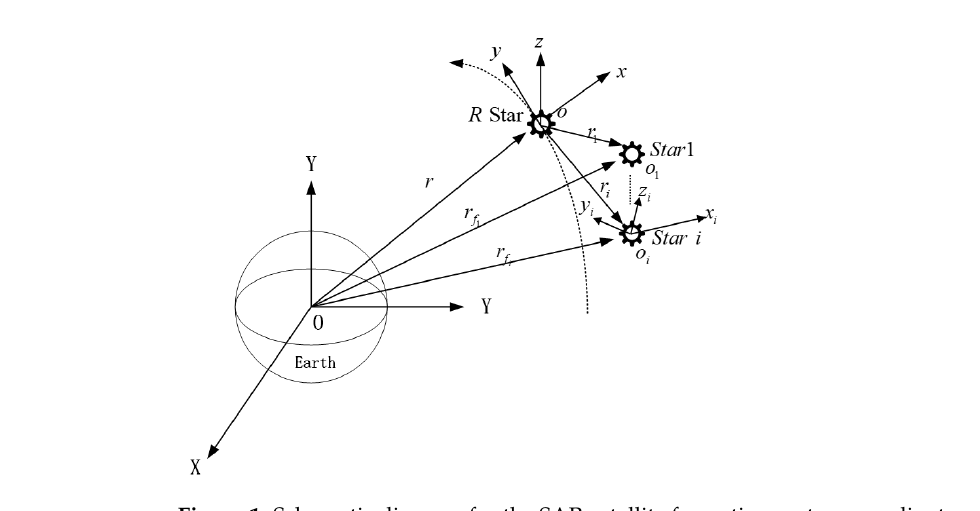
Figure 1. Schematic diagram for the SAR satellite formation system coordinates.